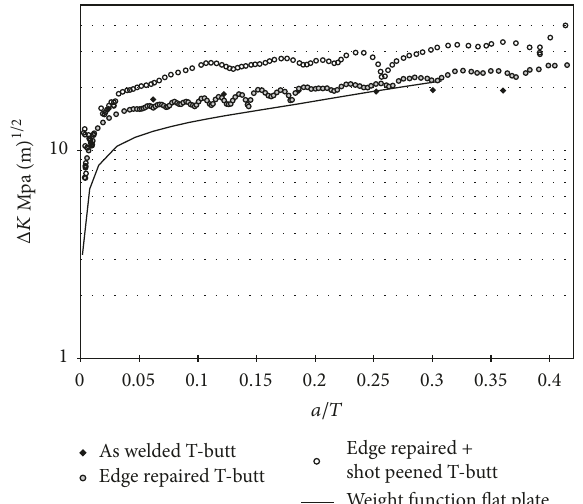
Figure 10: Δ𝐾 versus crack depth for fatigue tested specimens.